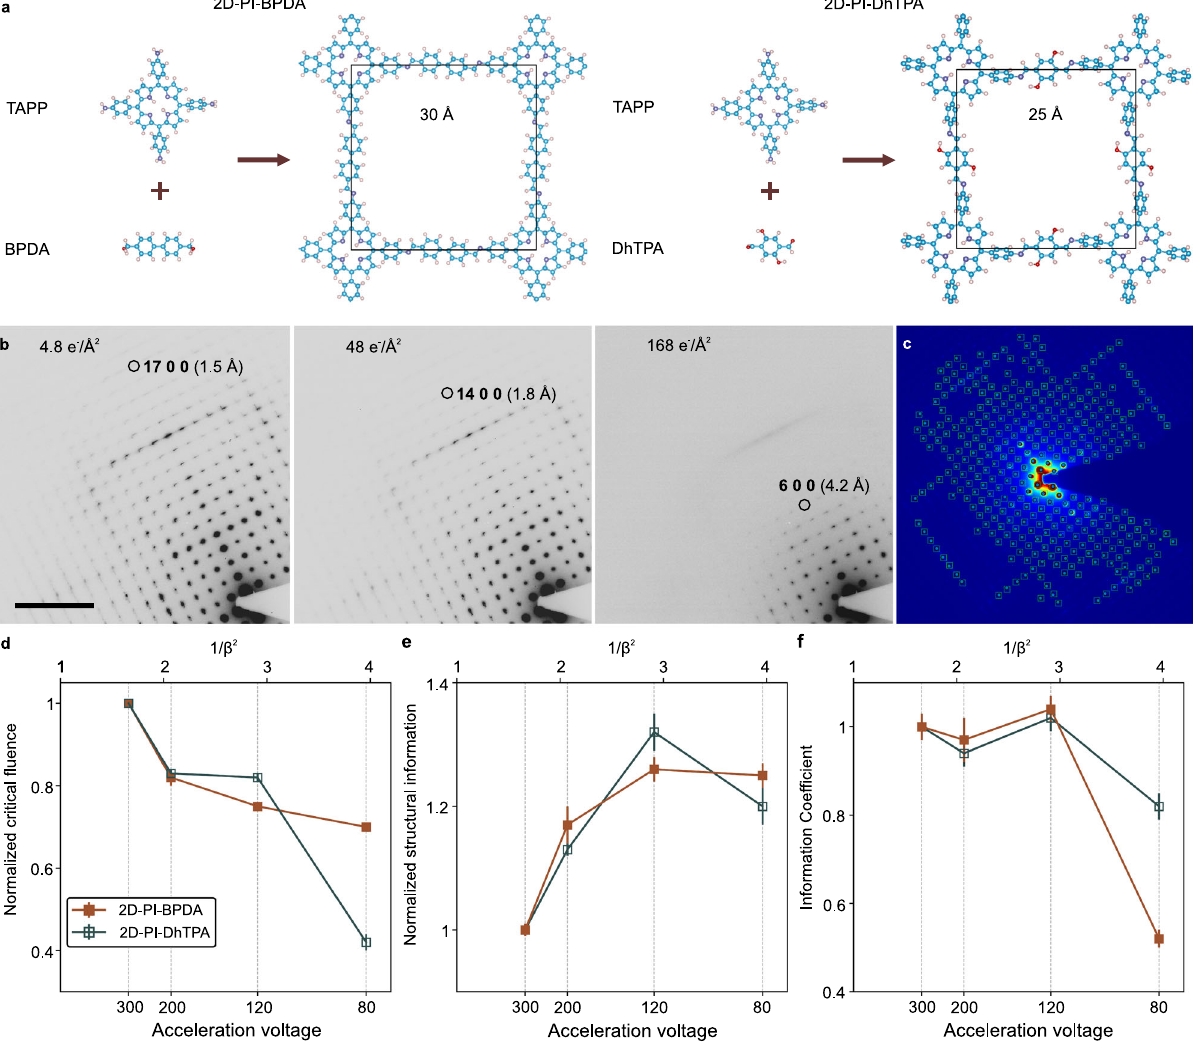
Fig. 1 Schematic structure and acceleration voltage optimization of 2D-PI-BPDA and 2D-PI-DhTPA. a The reaction scheme of 2D-PI-BPDA and 2D-PI- DhTPA (blue: C, purple: N, pink: H, red: O). b Selected images from a SAED pattern series on 2D-PI-DhTPA with a total fl uence of 4.8, 48, and 168 e − /Å 2 , respectively. Scale bar: 2 nm − 1 . c Automatic identi fi cation of diffraction spots via the neural network. d – f Critical fl uence for the resolution range from 5 to 6 nm − 1 (1.7 – 2.0 Å) ( d ) structural information proportion ( e ) and information coef fi cient ( f ) as a function of the acceleration voltage. All values are normalized to those at 300 kV. The error bar corresponds to the standard error of three measurements. The sienna and teal colored lines represent 2D-PI- BPDA and 2D-PI-DhTPA,